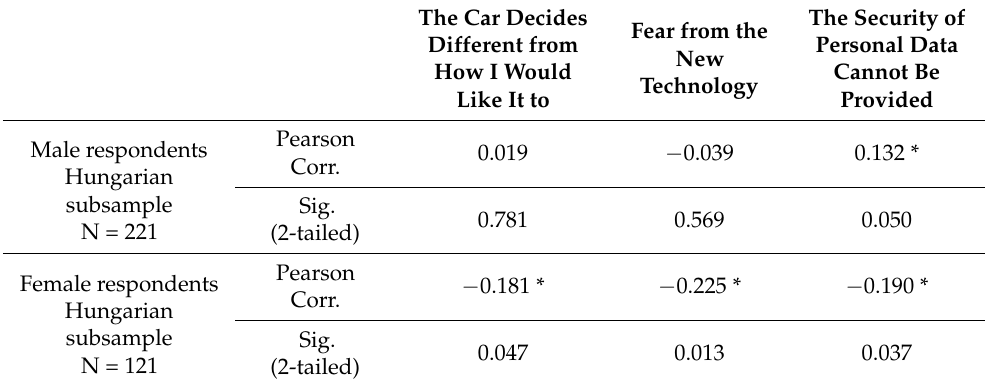
Table 3. The relationship of age and perceptions by gender in the Hungarian sample.